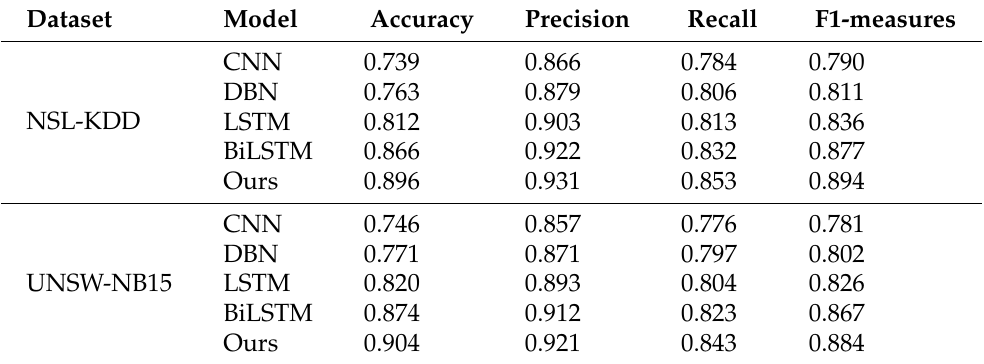
Table 4. The detection performance of IDD and baseline methods on different data